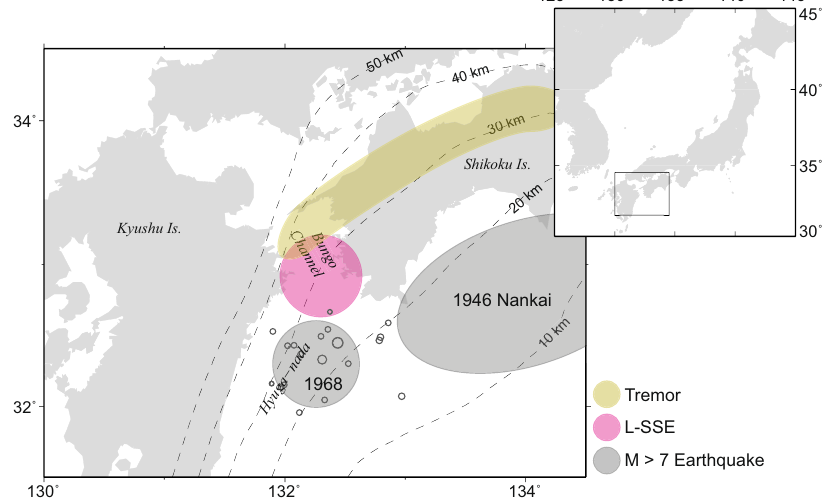
Figure 1. Distribution of various types of fault slips. Red circle approximates the source areas of L-SSEs. Grey circles are the source areas of the 1946 Nankai and the 1968 Hyuga-nada earthquakes. Yellow area approximates the source area of deep low-frequency tremors. Small circles represent hypocentres of earthquakes M > 3.0 and depth < 70 km from 1 April to 1 May 1968 as determined by the Japan Meteorological Agency (JMA). Contours indicate the depth (in km) of the upper surface of the descending Philippine Sea plate 30 . Characters in italics are geographical names. Rectangle in the inset represents the location of the study area. The map is created by Generic Mapping Tools software (GMT v4.5.12; http://gmt.soest.hawaii.edu/) 33